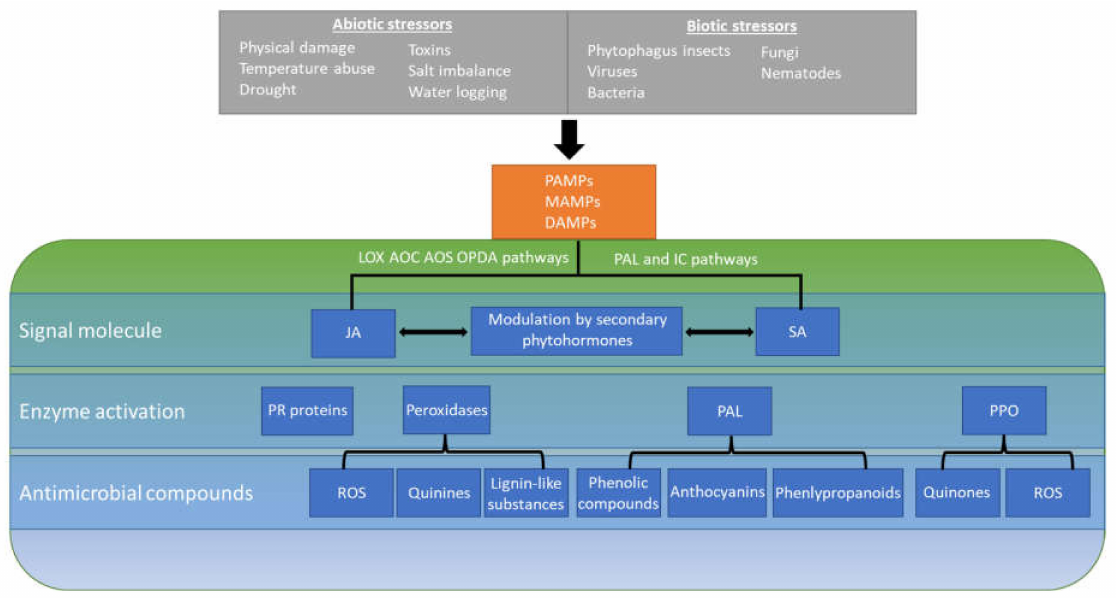
Figure 1. Plant basal defenses and production of antimicrobial compounds. Recognition of pathogen-associated molecu- lar patterns, microbe-associated molecular patterns, and damage-associated molecular patterns (PAMPS, MAMPS, and DAMPS) trigger activation of the jasmonic acid (JA)- and salicylic acid (SA)-mediated defense responses. Through various interconnected pathways, JA and SA, along with secondary phytohormones, lead to an accumulation of peroxidases, phenylalanine ammonia lyase (PAL), polyphenol oxidase (PPO), and the expression of pathogenesis-related (PR) genes, some of which encode defensins. Together, peroxidases, PAL, and PPO are responsible for the generation of compounds important for defending against abiotic and biotic stressors. These pathways and resulting bioactive molecules may be harnessed to control the contamination of plants by enteric